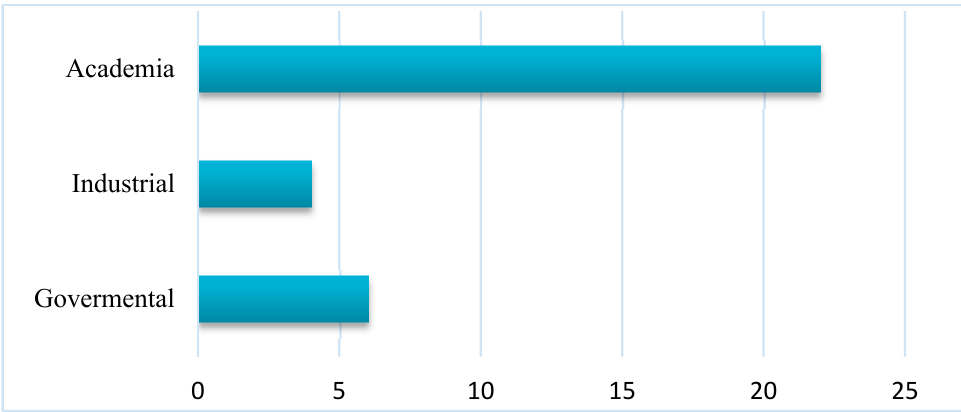
Figure 3. Literature overview: the number of literature types for different organizations. Figure 4. Literature overview: number of studies for literature type.